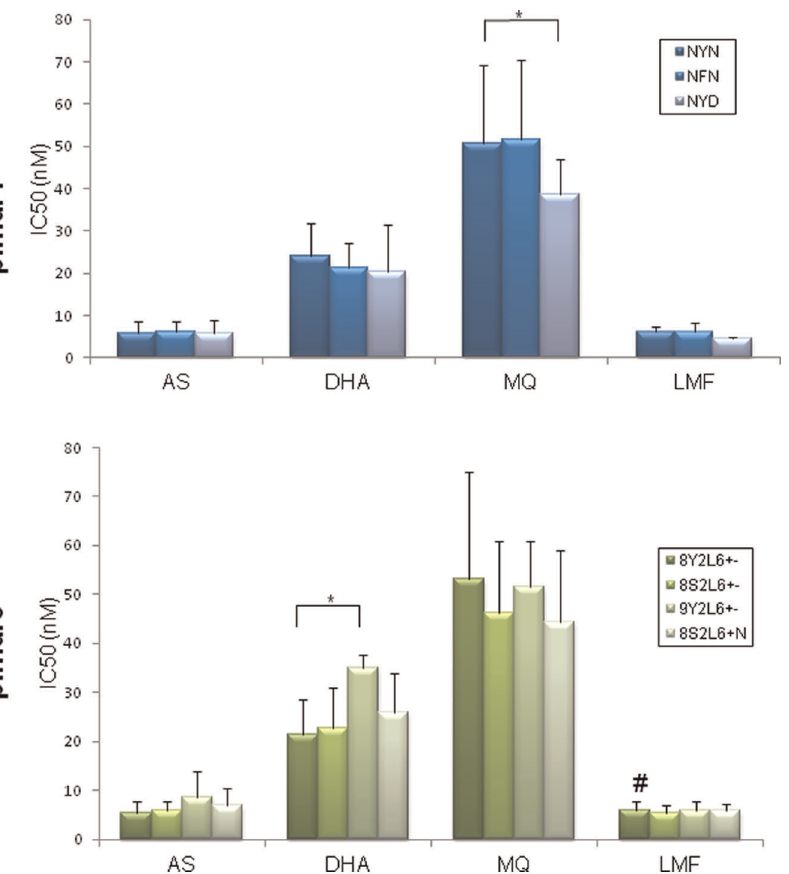
Figure 3. Association of haplotypes in candidate genes with drug responses. Only association of major haplotypes in pfmdr1 and pfmdr6 with in vitro responses to artesunate (AS), dihydroartemisinin (DHA), mefloquine (MQ) and lumefantrine (LMF) are plotted. IC 50 values are shown as mean + standard deviation. * indicates significant difference ( P , 0.05) in sensitivity between the haplotypes after Bonferroni correction. # indicates that this pfmdr6 haplotype was significantly more sensitive to LMF than 3D7.